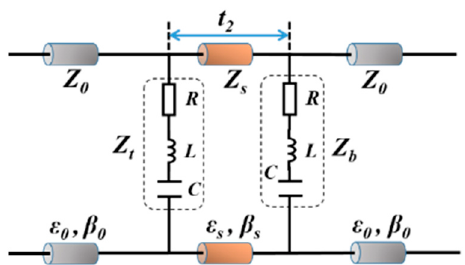
Figure 2. Equivalent circuit model (ECM) of the proposed absorber.